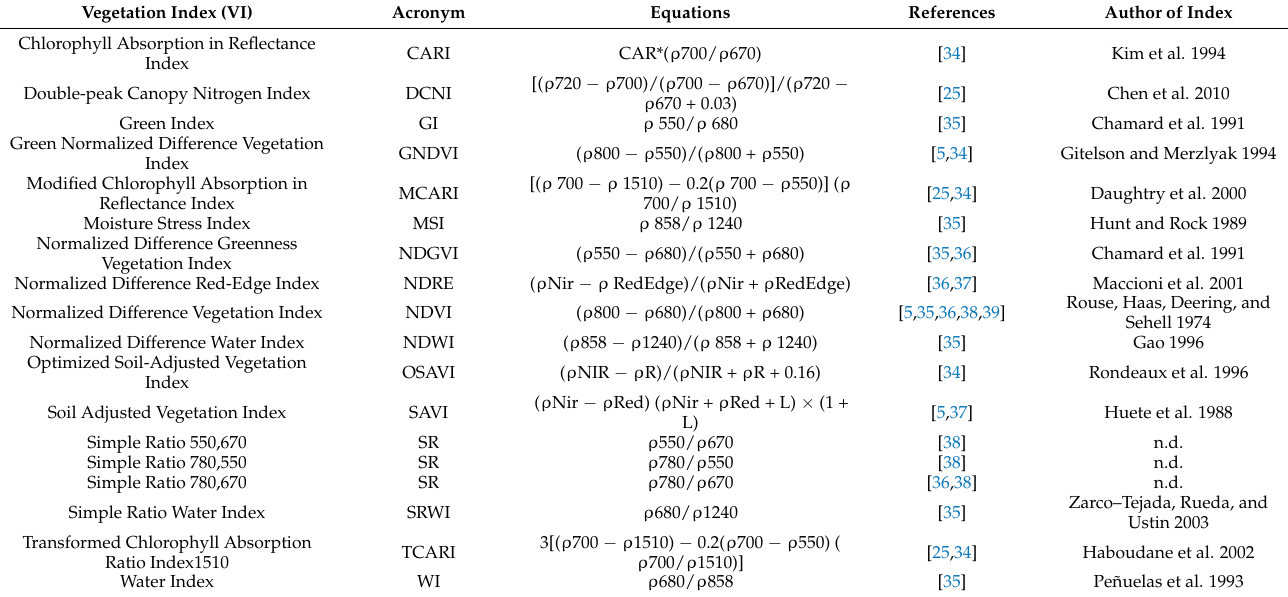
Table 1. Shows the main VI used on olive trees, conducted by different